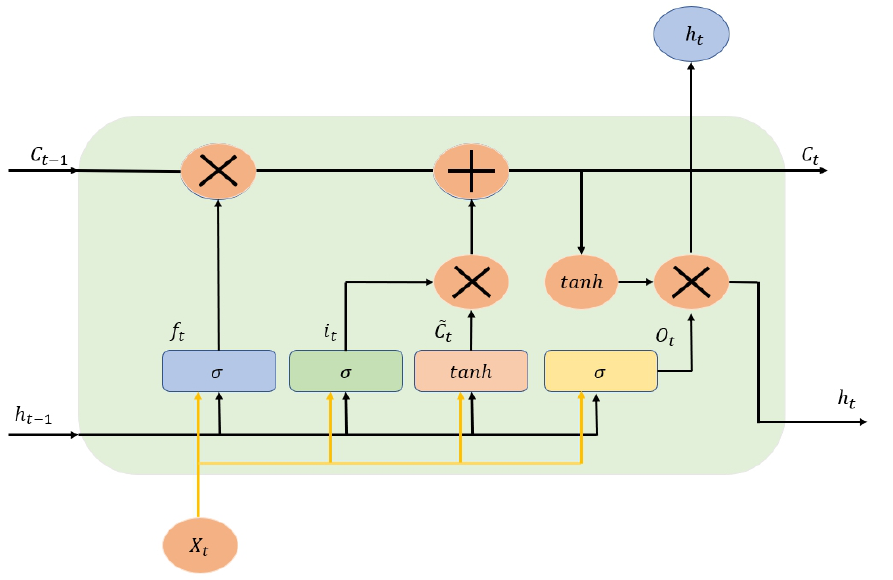
Figure 6. Long short-term neural network